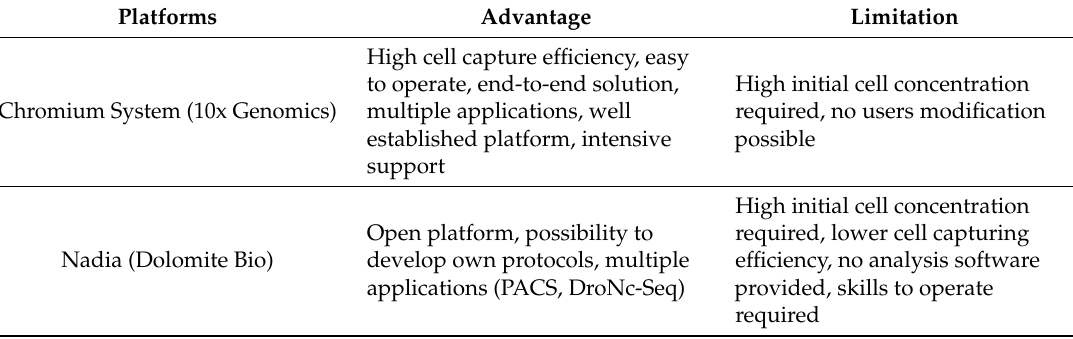
Table 3. Advantages and limitations of commercially available instruments for single-cell collection and